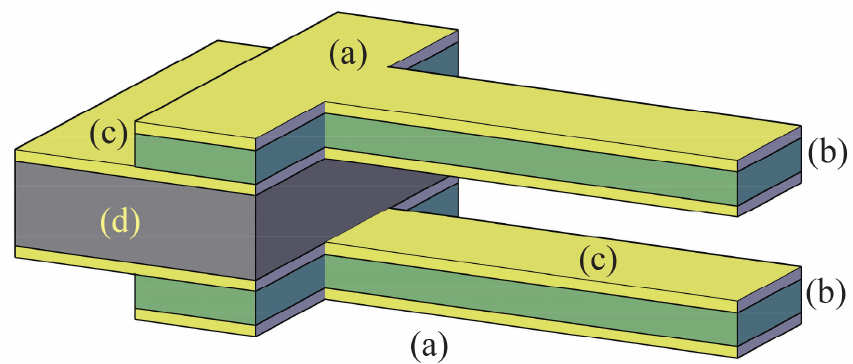
Figure 1. A schematic view of the microsystem: outer layers with a same voltage V 0 ( a ); structural material for the beams ( b ); internal layers with voltage V i ( c ) and structural layer for the handle ( d